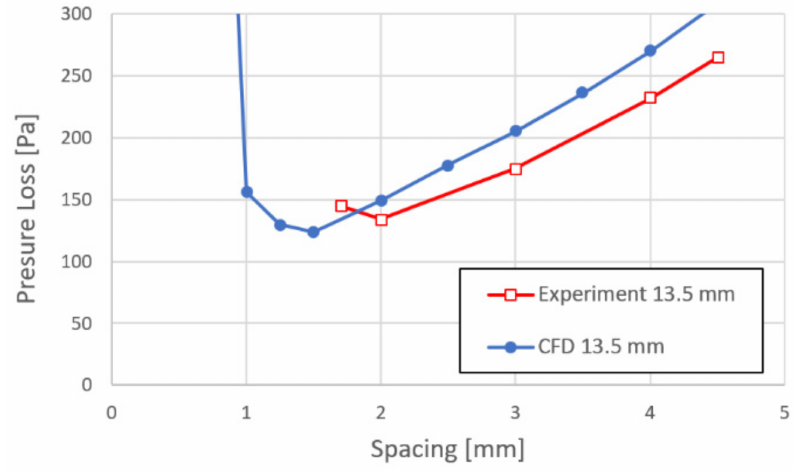
Figure 22. Comparison of calculated pressure drop of pleated filter at flow rate 70 L/min.